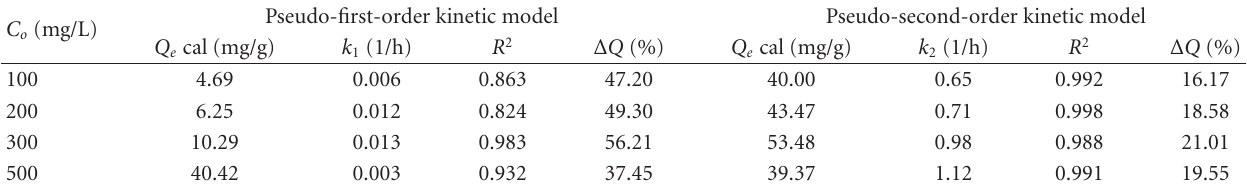
Table 3: Pseudo-first-order and pseudo-second-order constants for the adsorption of phenol on BK at 25 ◦ C. C o (mg/L)